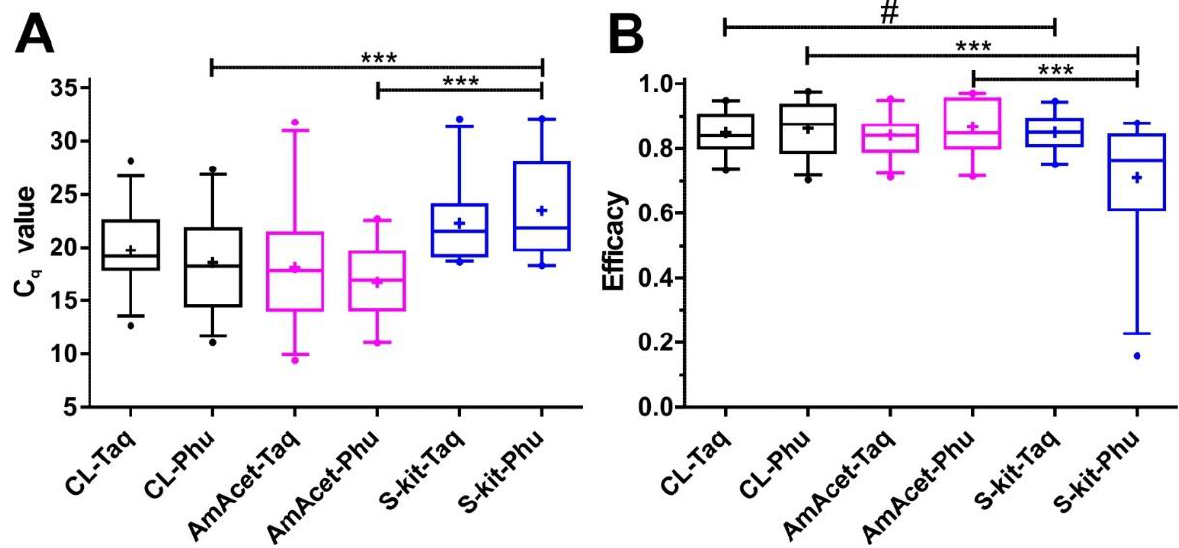
Figure 4. Comparison of the cycles of quantification (C q value) ( A ) and PCR efficacies ( B ) between different DNA preparation methods and amplification protocols for a Tunga penetrans partial ITS-2 PCR. Template DNA was obtained (i) as a crude lysate (CL) by simple boiling of mechanically cracked larvae, (ii) by proteinase K digestion followed by precipitation with ammonium acetate (AmAcet) or (iii) using a soil DNA isolation kit (S-kit). Amplification was performed as real-time PCR using either the FIREPol ® Taq (Taq) or the Phusion ® (Phu) DNA polymerase protocols. Boxplots show medians with interquartile ranges and whiskers represent 5 and 95% quantiles. Outliers are indicated by dots. The mean of all values is shown as a cross. Paired t -tests for the same template DNA using either Taq or Phusion ® polymerase protocols did not reveal any significant differences. Comparison between different DNA preparation methods using the same amplification protocol were conducted using one-way ANOVAs. Hashtags were used to indicate differences between the DNA preparation methods for the Taq polymerase protocol, while asteriks indicate differences between the preparation methods for the Phusion ® protocol. #, p < 0.05; ***, p < 0.001.